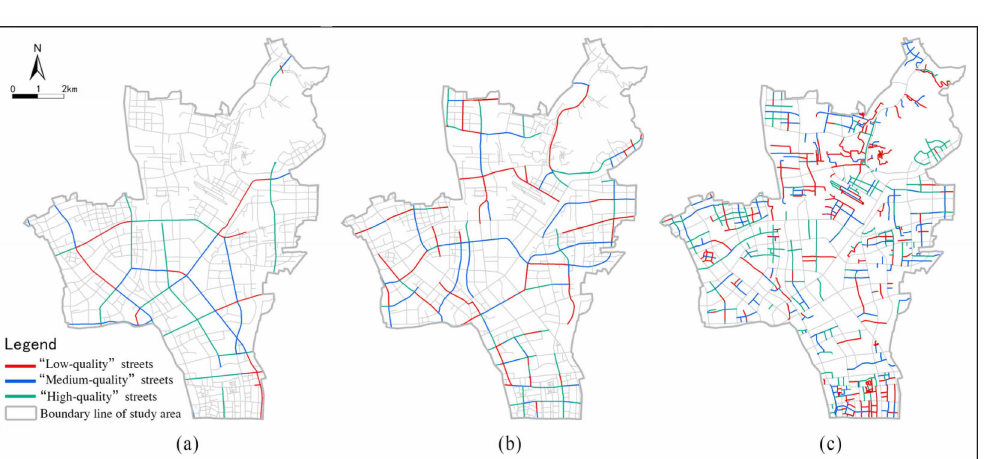
Figure 13. Classification results of street spatial quality at different grades. ( a ) Arterial road; ( b ) Secondary trunk road; ( c ) Branch